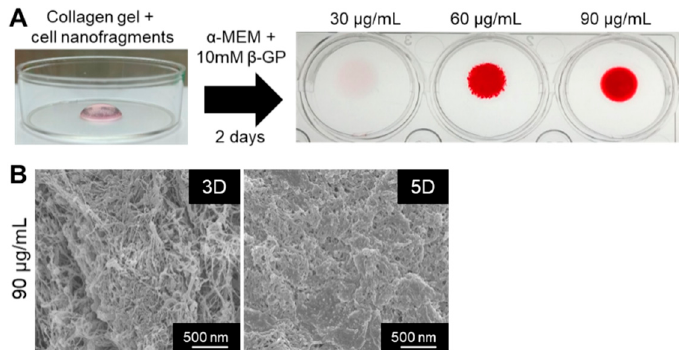
Figure 10. ( A ) Fabrication of a 3D collagen-cell nanofragment-mineral complex mimicking a bone-like structure using ATDC5 cell-derived nanofragments and collagen gel. The collagen-cell nanofragment-complex can mineralize in just 2 days with cell nanofragment concentrations of 60 µg/mL and 90 µg/mL, but not at a concentration of 30 µg/mL. ( B ) SEM images of the 3D collagen-cell nanofragment-mineral complex mimicking a bone-like structure. Note the deposition of minerals onto the collagen fibers after 3 days (3D), and the densely compacted minerals after 5 days of incubation in α -MEM supplemented with 10 mM β -GP.